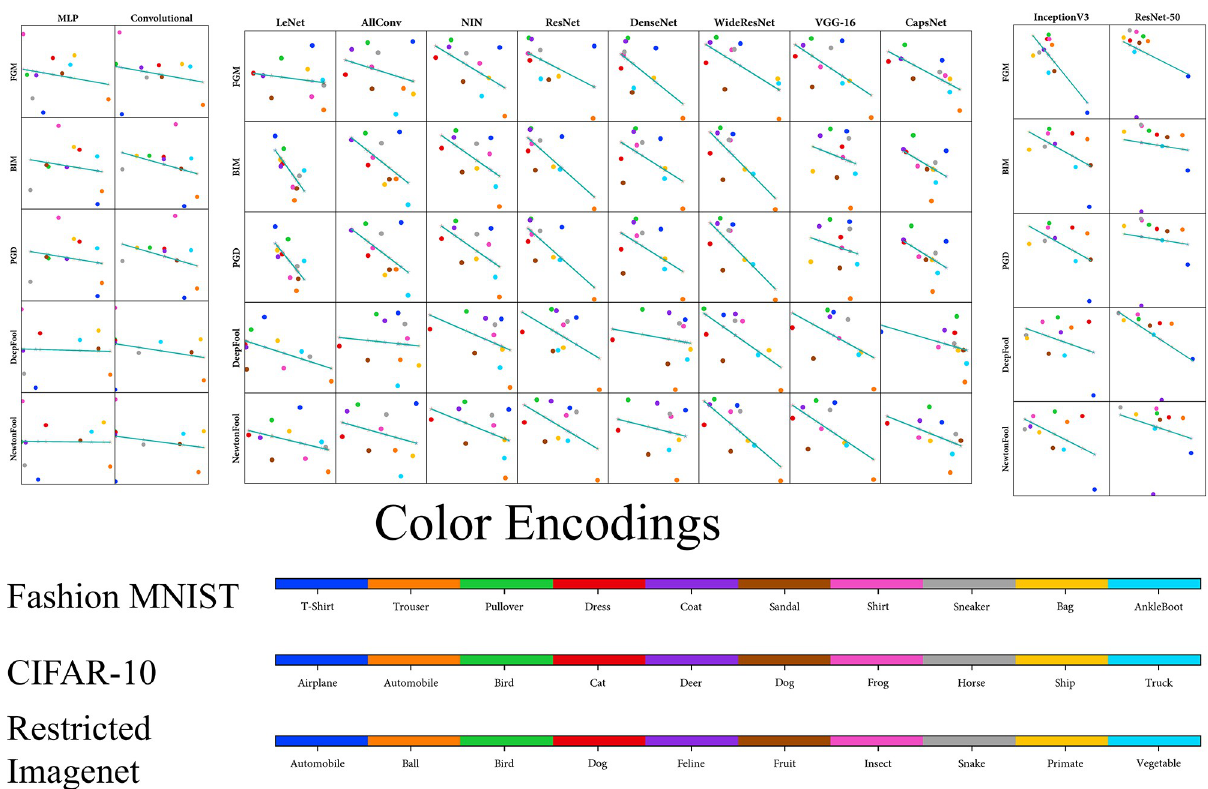
Fig 5. Visualisation of Pearson correlation of Davies-Bouldin Metric (DBM) with Mean L 2 Score of adversarial attacks (Table 3). Here, the x-axis represents the Mean L 2 Scores while the y-axis represents the DBM values. Each point represent a DBM value and Mean L 2 Score for a labelled class. Slope of the line determines the pearson correlation coefficient value while lower dispersion of points from the line determines a low p-Value.